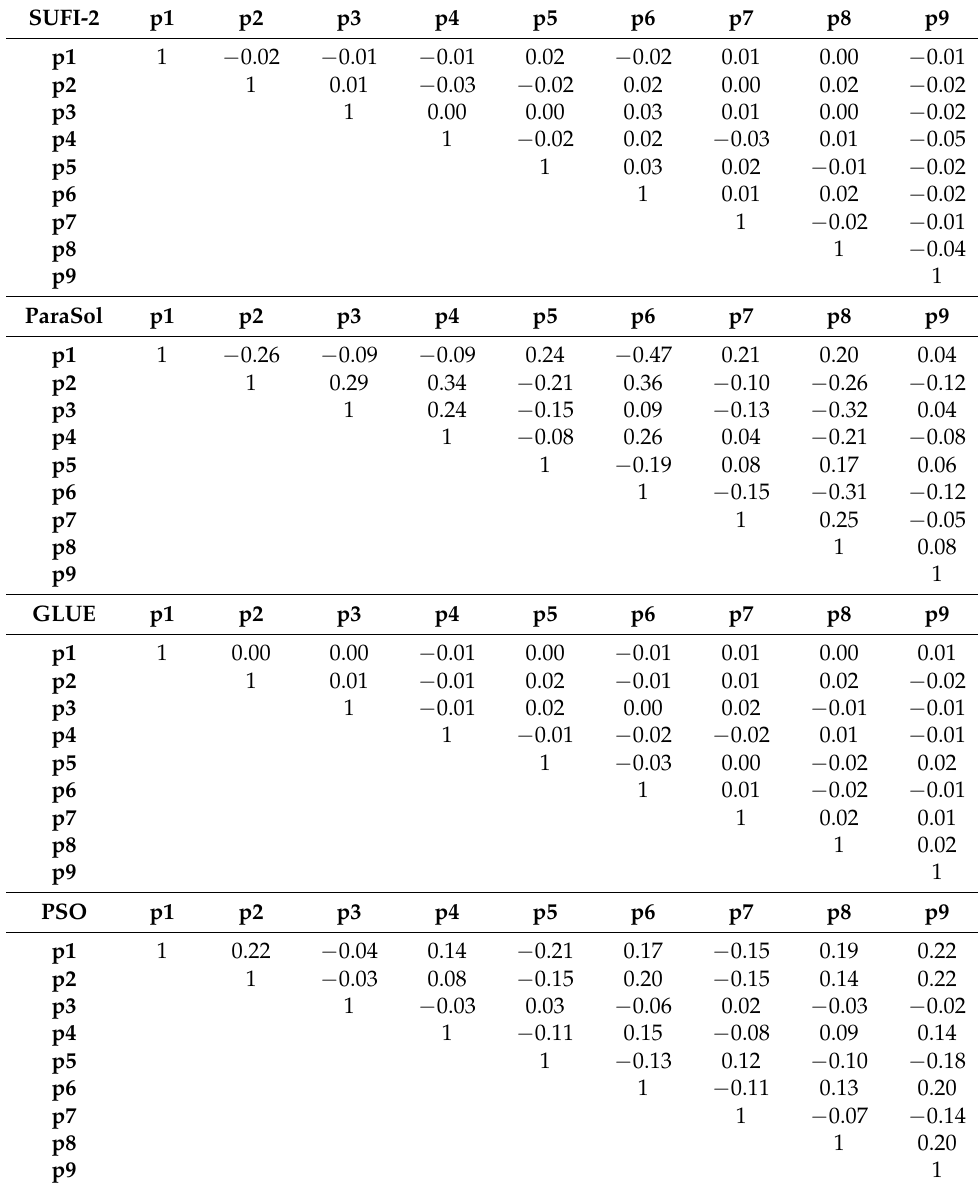
Table 6. Parameter combination correlation coefficient matrix generated by SUFI-2, ParaSol, GLUE, and PSO (Notation: p1, p2, p3, p4, p5, p6, p7, p8, and p9 represent ALPHA_BNK, CH_K2,